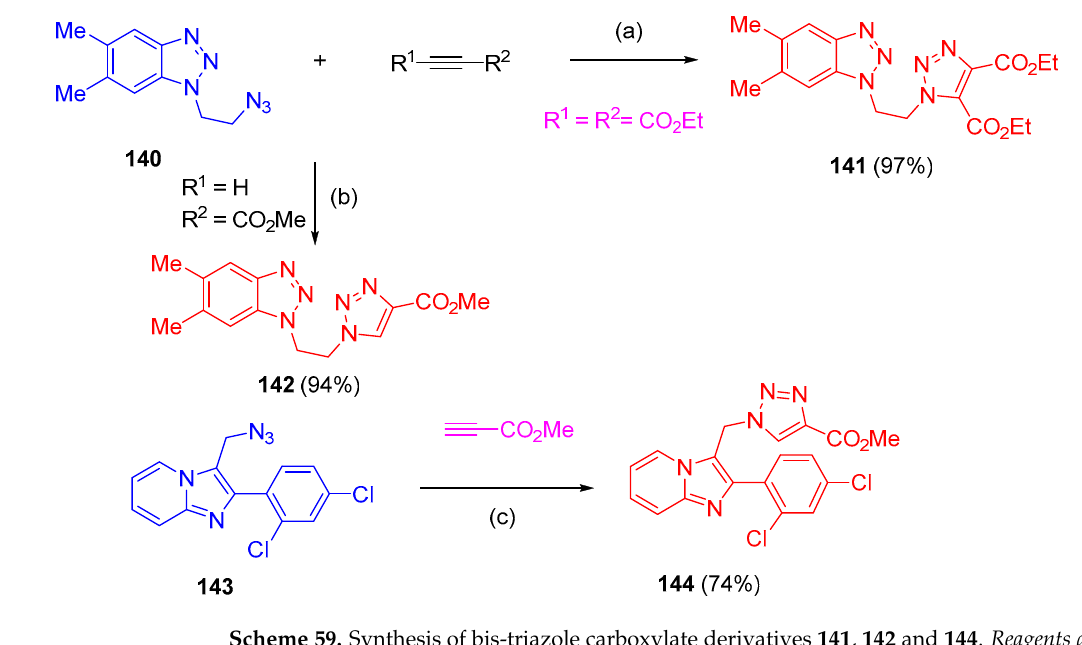
Scheme 59. Synthesis of bis-triazole carboxylate derivatives 141 , 142 and 144 . Reagents and conditions: